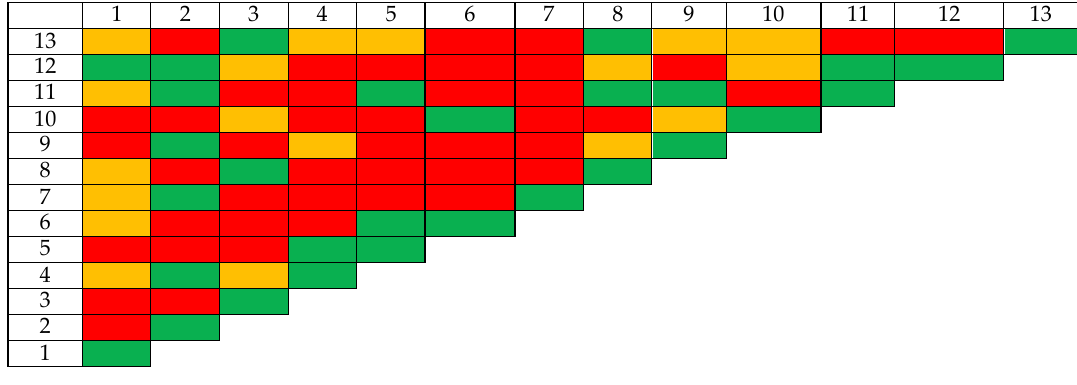
Table 2. Vegetative compatibility among the 13 Geosmithia morbida isolates. Red= incompatible (I); yellow = likely compat - Table 2 1 ible (LC); green = compatible (C).